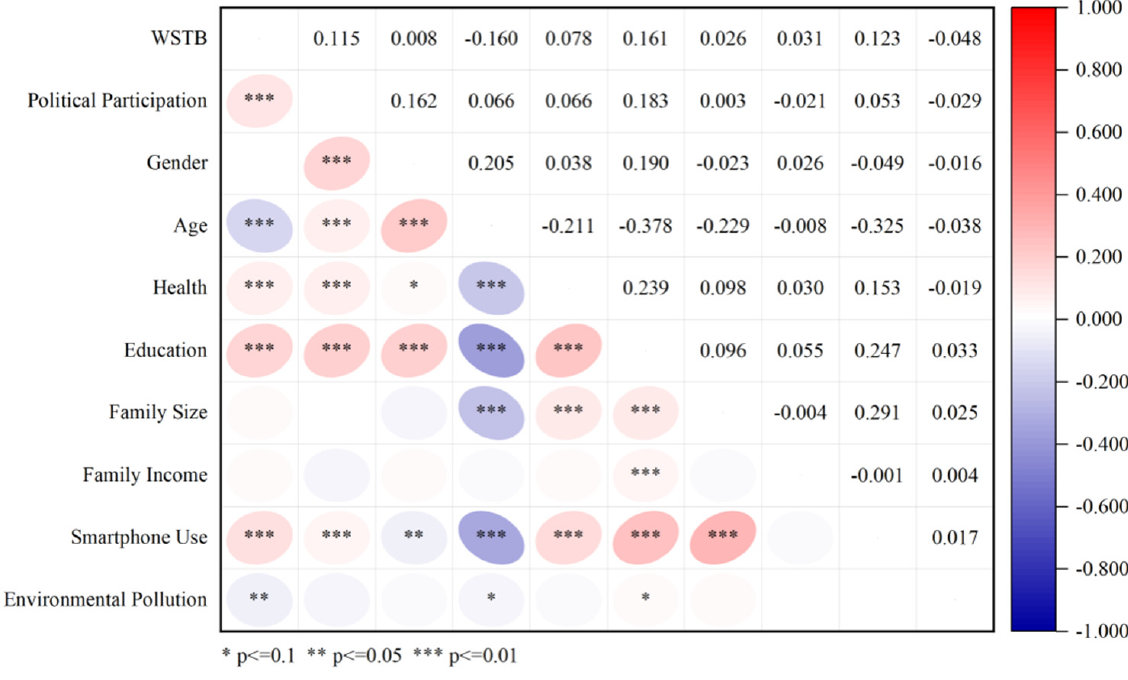
Figure 1. The heatmap for the matrix of Pearson’s correlation coefficients.